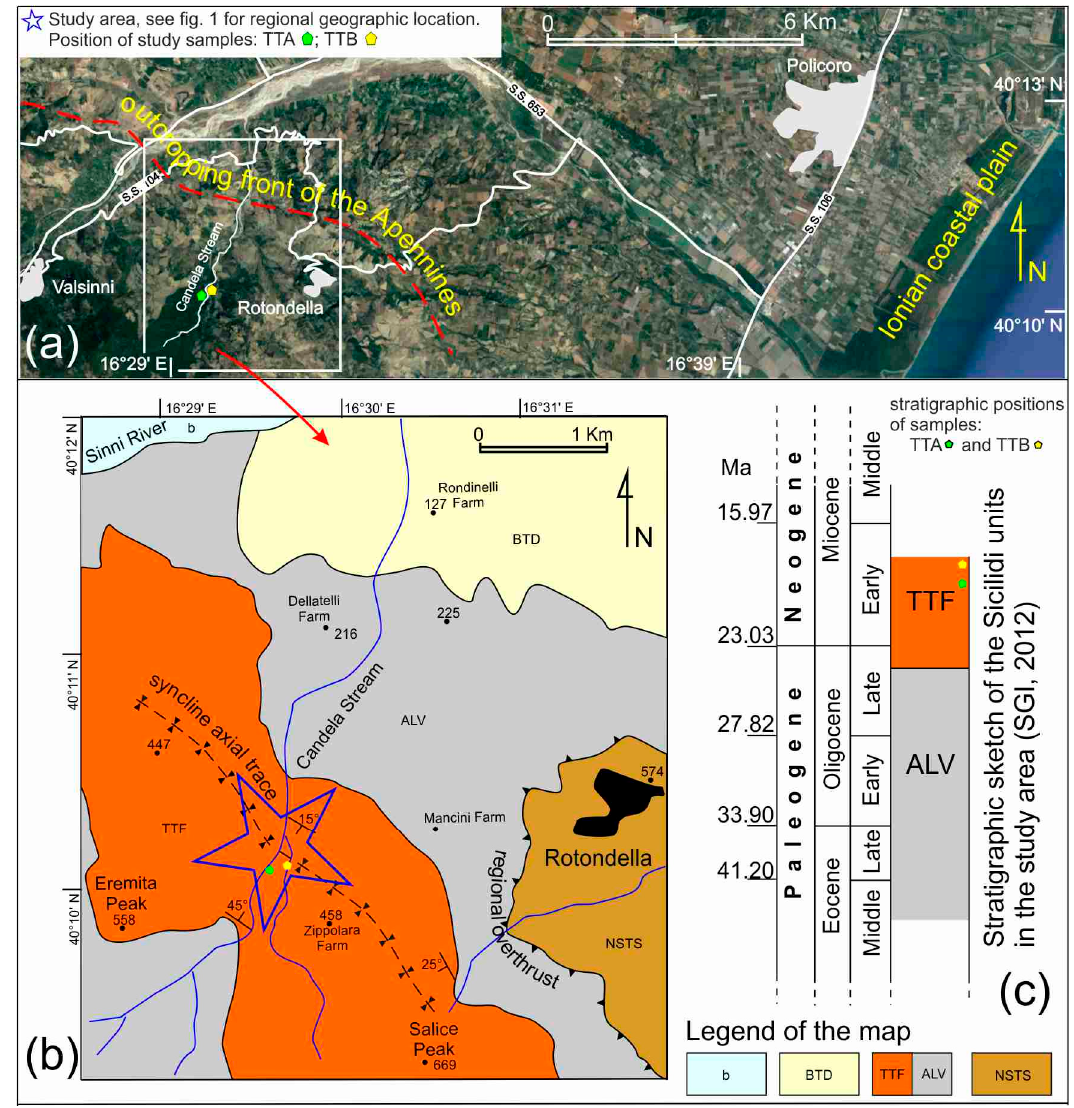
Figure 3. ( a ) Study area, modified from Google Earth. ( b ) Geological map of the study area, modified from [33]. ( c ) Stratigraphic sketch of the Sicilidi units in the study area modified from [32] showing the stratigraphic position of the study samples. NSTS, Nova Siri Tectonic Subunit (Cretaceous–Middle Miocene); ALV, Argille Varicolori Superiori Formation (Middle Eocene–Late Oligocene); TTF, Tufiti di Tusa Formation (Late Oligocene–Early Miocene); BTD: Bradanic Trough Deposits (Middle Pliocene Pleistocene); b, Alluvial deposits (Late Pleistocene-Olocene).